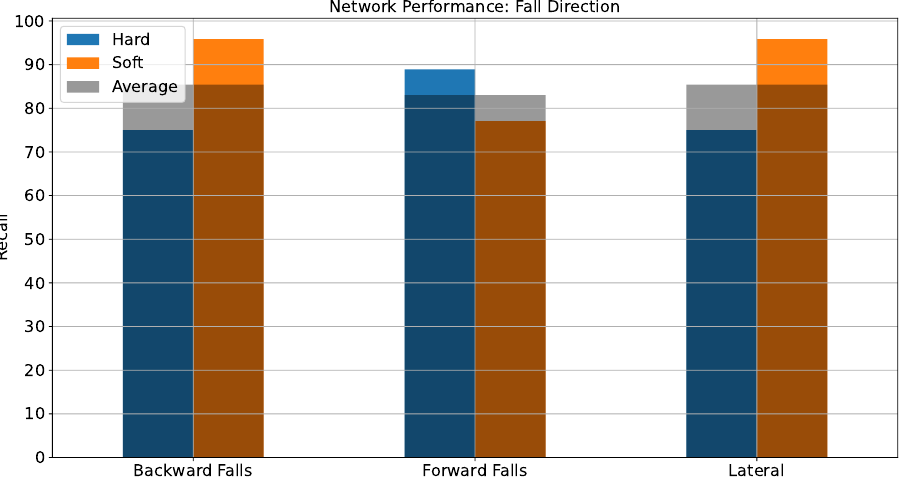
Figure 4. Network performance for different fall directions.